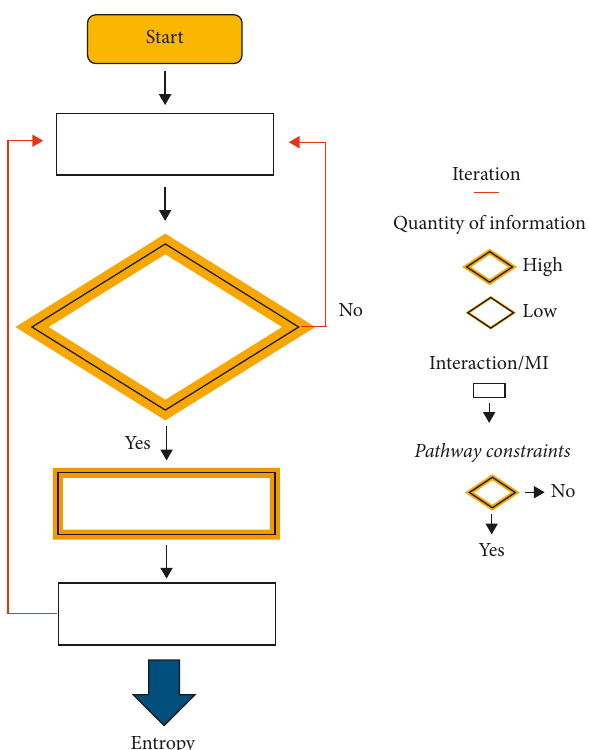
Figure 7: Physical and mathematical aspects of workflows. Rep- resentations and elements of